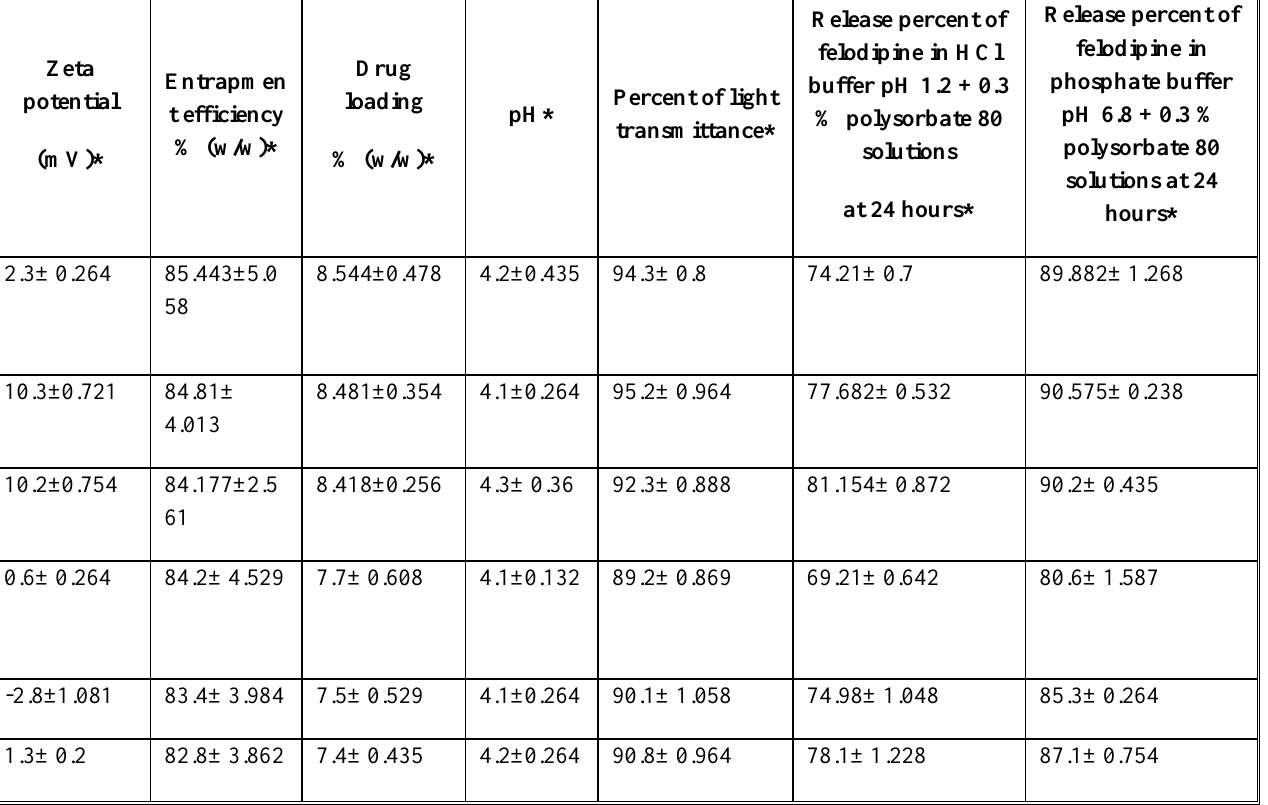
Table (2). Summary of characterization results of felodipine LPHNs formulations (HF1-HF6).